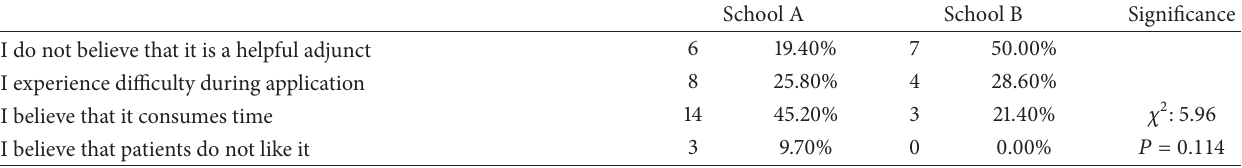
Table 6: Major reasons for not planning to use the rubber dam in future